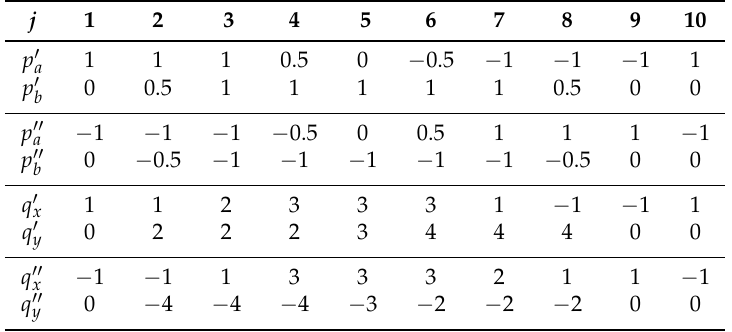
Table 2. Control points for the “C” beam shape